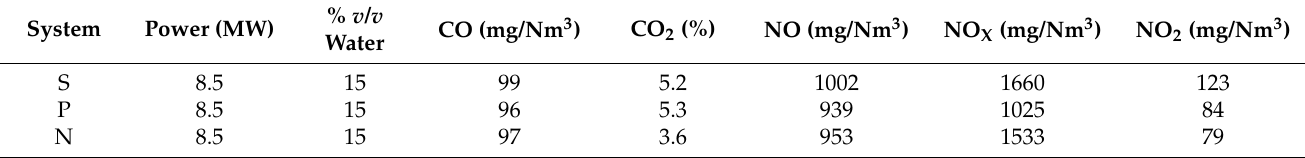
Table 6. Results of exhaust gas emissions into the atmosphere.